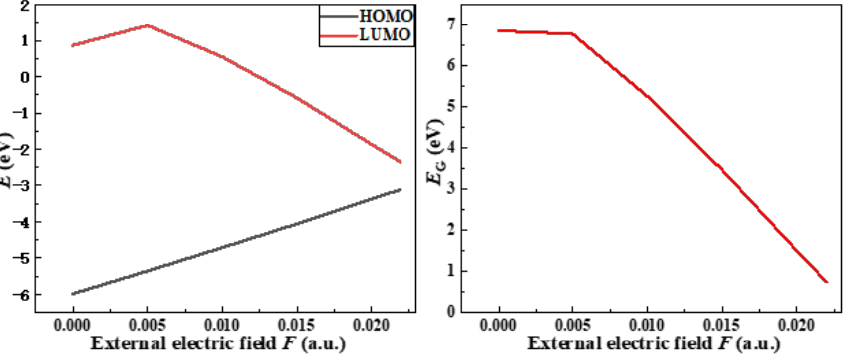
Figure 6. The variations of molecular frontier orbital energy level and energy gap with electric field intensity.